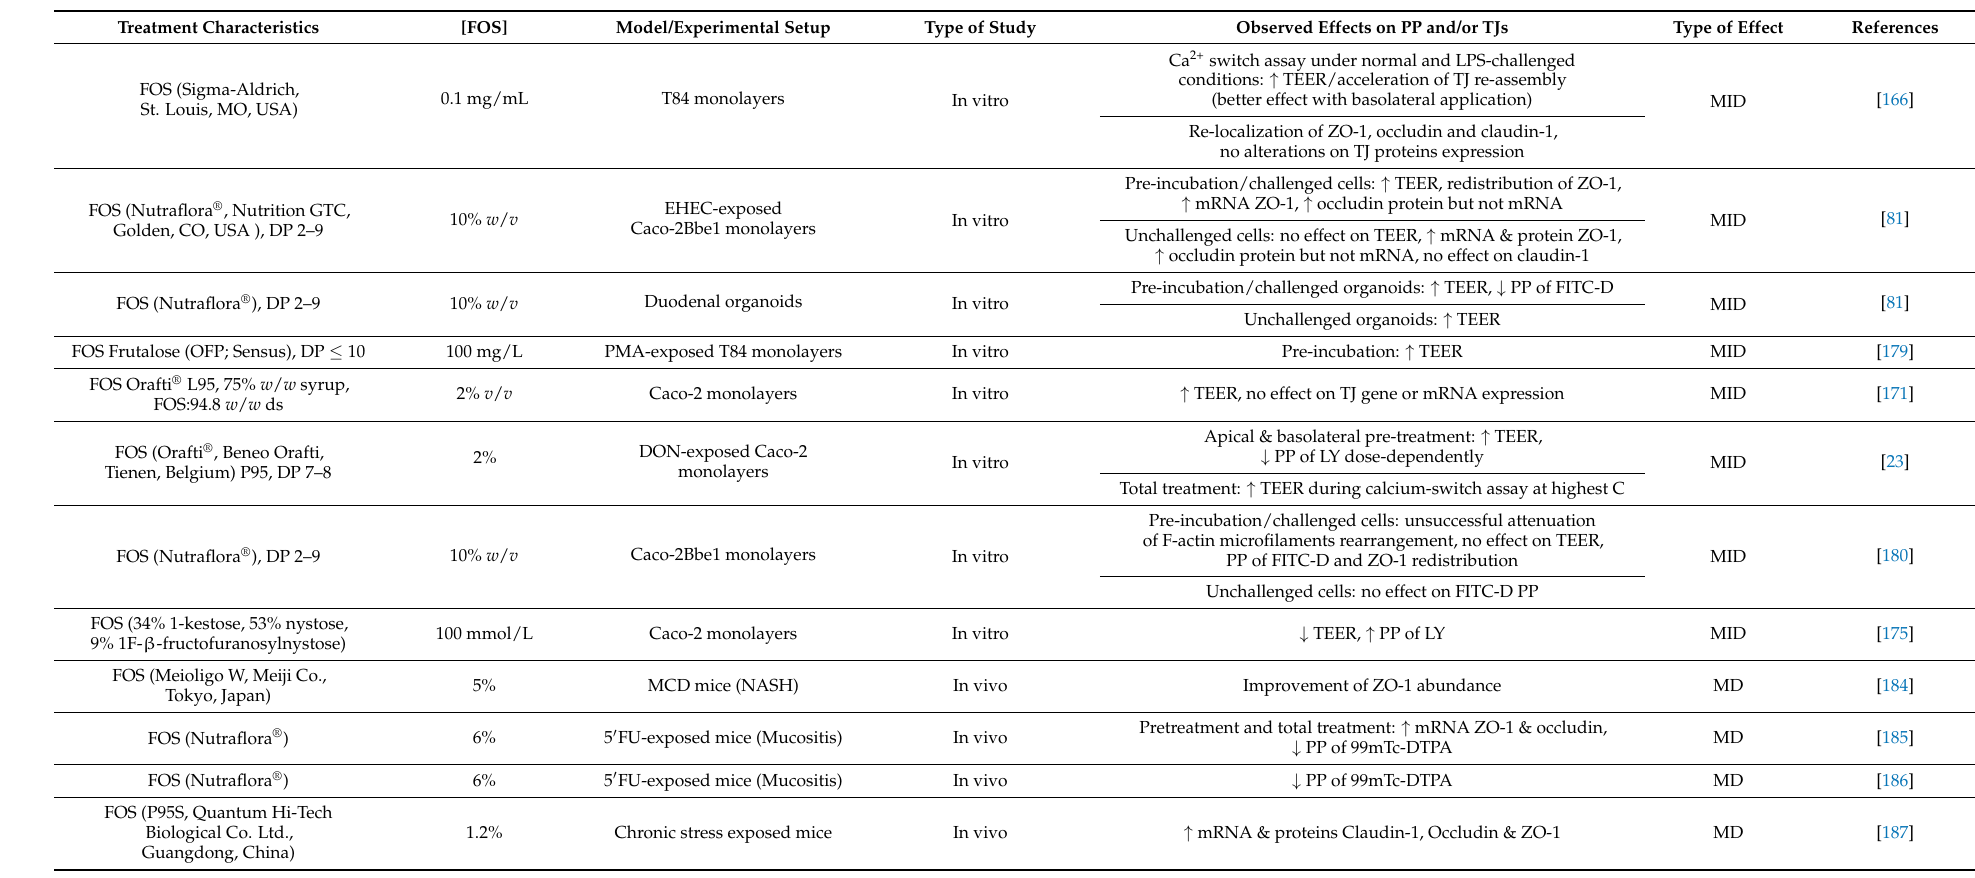
Table 1. Microbiota-dependent and independent effects of FOS on paracellular permeability and/or